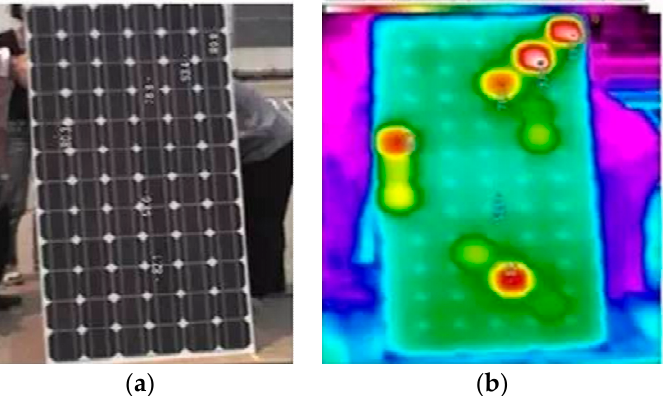
Figure 1. Hot spot effect of photovoltaic module: ( a ) photovoltaic module; ( b ) infrared image of the photovoltaic module.